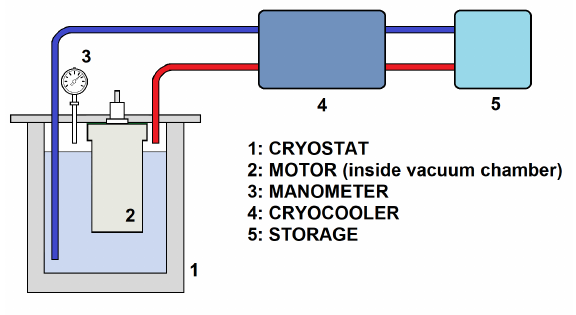
Figure 2. Electric machine cooled in the cryostat.